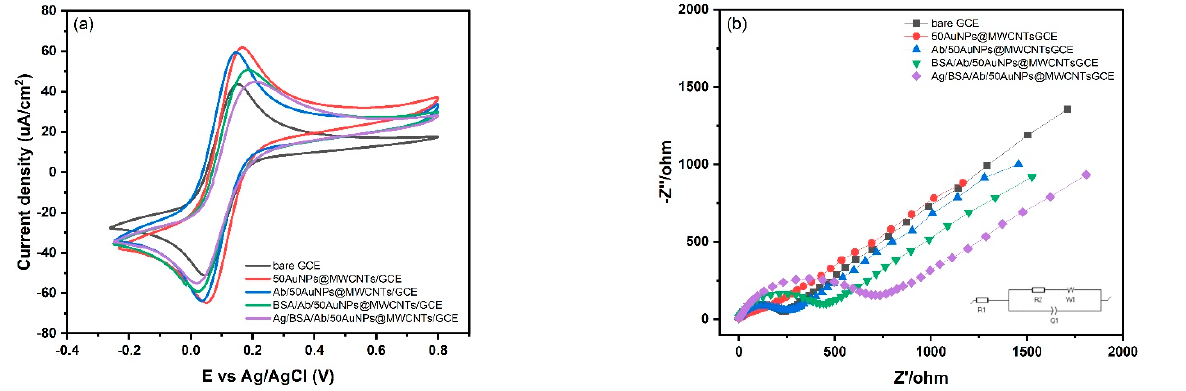
Figure 5. ( a ) CV profile, ( b ) EIS spectra of the step-by-step immunosensor in 5 mM [Fe(CN) ₆ ] 3 − /4 −